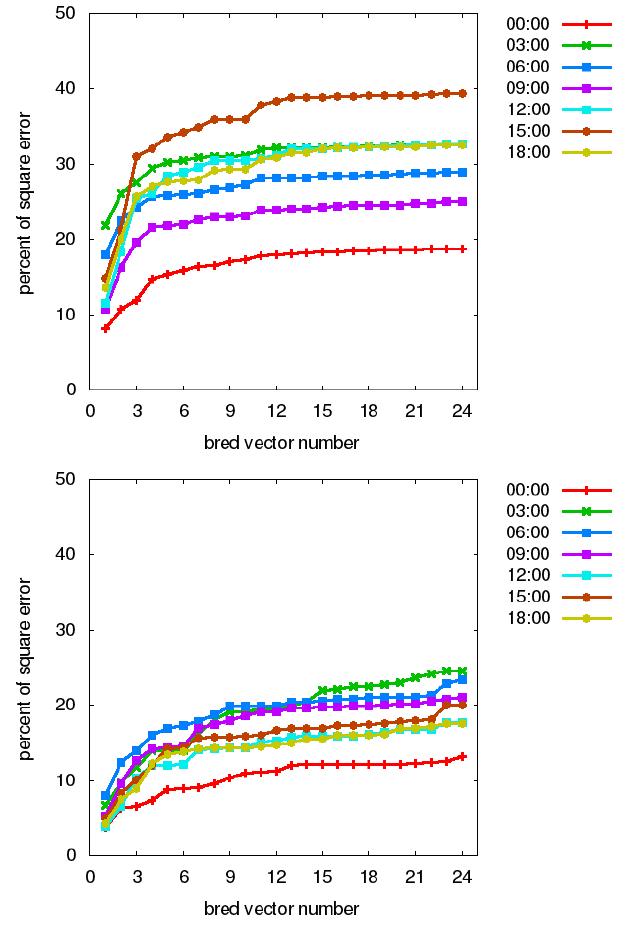
Figure 6. Square norm of error orthogonal projection onto subsets of bred vectors (percentage of error square norm) as a function of subspace dimension. Different curves in each panel correspond to different times (UTC, 26 September 2006). Top panel: control tra- jectory 18H (large initial error), rescaling period 30min, rescaling rms TUV norm 0.36. Bottom panel: control trajectory R21 (small initial error), rescaling period 15min, rescaling rms TUV norm